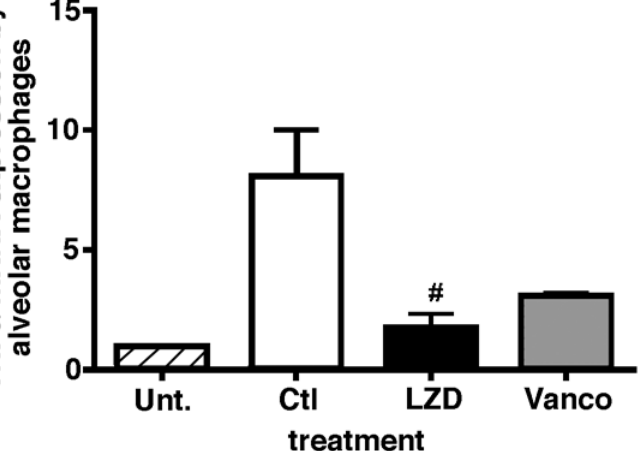
Figure 5. Macrophages harvested ex-vivo from LZD treated mice have decreased expression of TNF- α as compared to saline treated animals post bacterial challenge. WT mice were infected with H1N1 100 pfu i.n. and on day 7 challenged with 5×10 7 cfu cMRSA i.t., infected mice were treated with either vehicle or antibiotics LZD (80mg/kg i.p.) or Vanco (110 mg/kg i.p.). BAL was performed 24 hours post